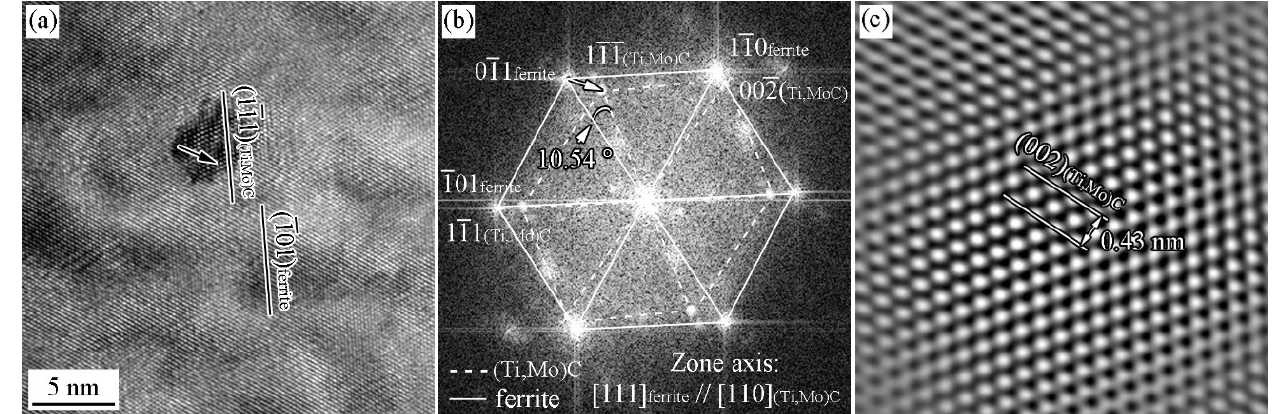
Figure 10. HRTEM image of precipitates and the ORs between the precipitates and ferrite matrix in the Ti-Mo steel produced by process II with cooling rate 20 °C/s ( a ) HRTEM image; ( b ) FFT diffractogram; ( c ) IFFT diffractogram.